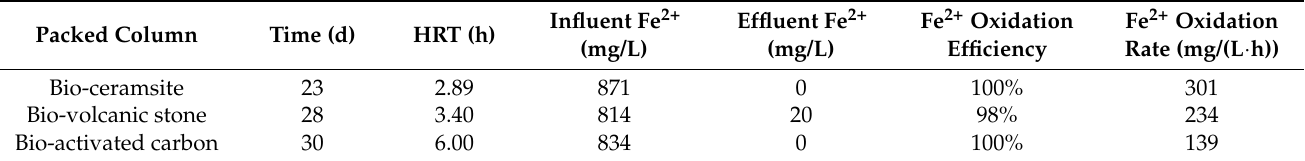
Figure 7. Variation in the oxidation rate of Fe 2+ in each packed column under different influent concentrations and HRT conditions. Table 1. Comparison of the oxidative capacity of the three packed